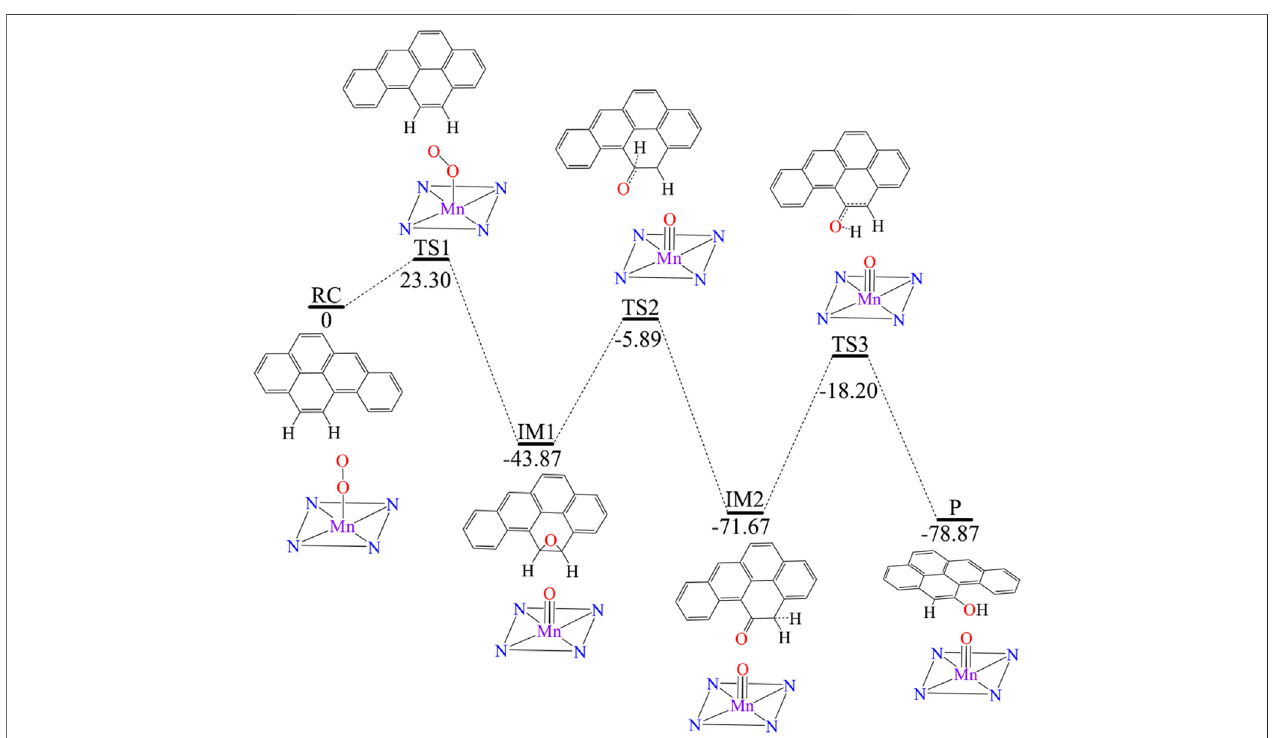
FIGURE 3 | Predicted reaction pathway for the generation of 11-OH-BaP from BaP via [Mn]-O-O corrolazine catalytic oxidation in the absence of an electric fi eld.